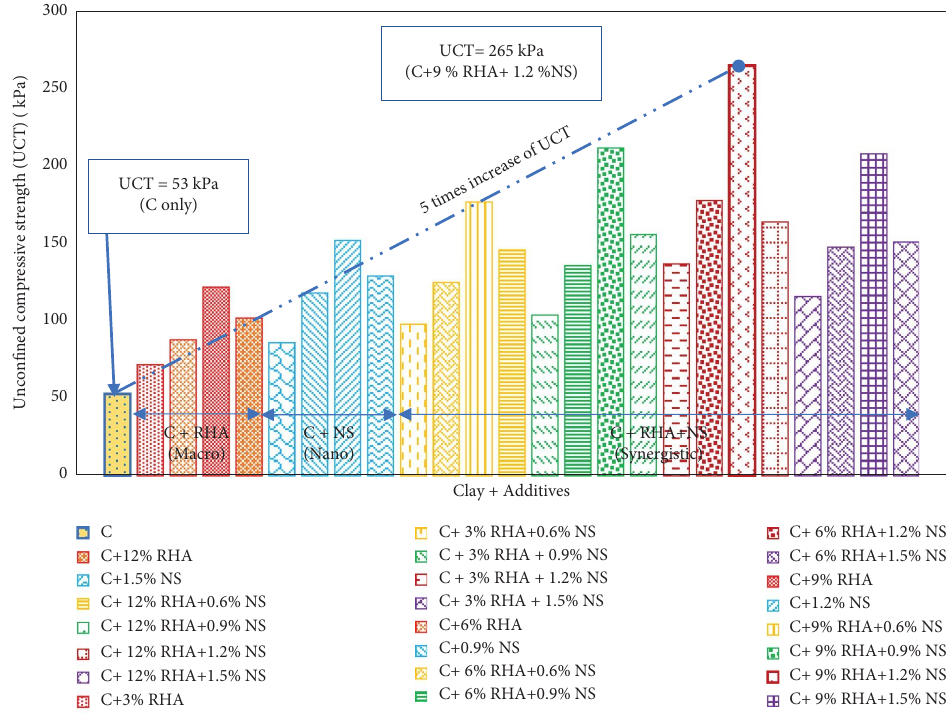
Figure 5: UCT of clay and blends of clay plus RHA and